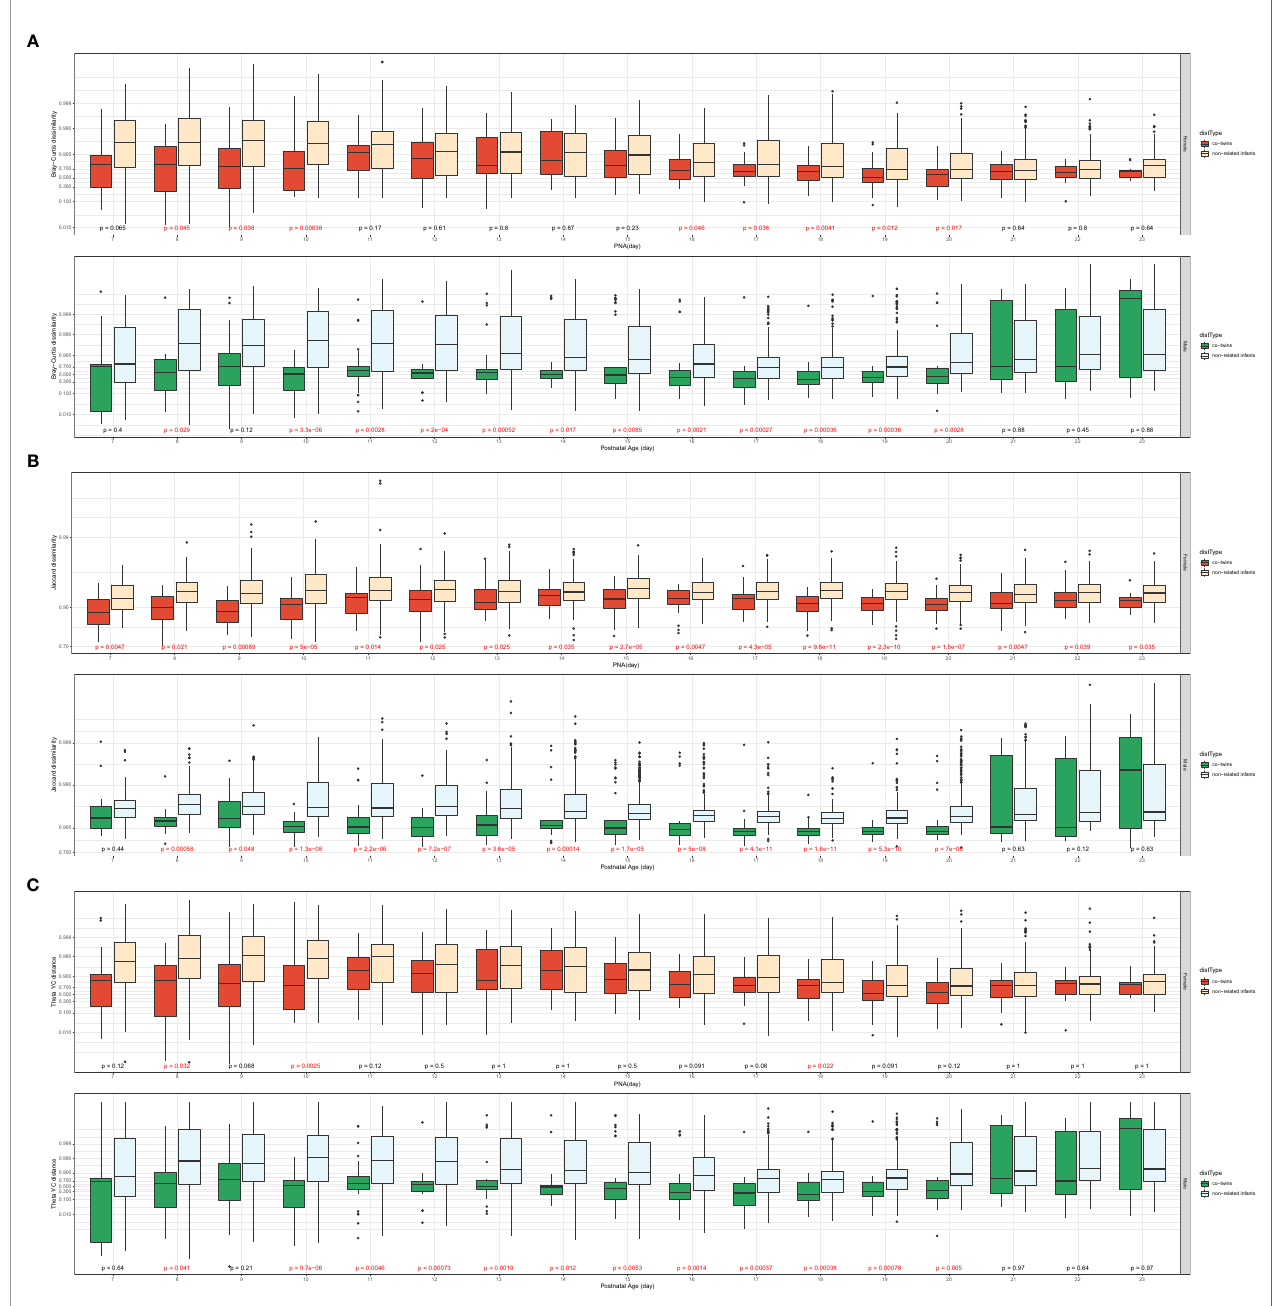
FIGURE 3 | Comparison of the b -diversity of the co-twins/triples with non-related infants from the same sex ( A : Bray-Curtis dissimilarity; B : Jaccard dissimilarity; C : Theta YC distance). In each of the sub fi gures, top panel: Female T/T (Mann-Whitney U test, signi fi cant p values colored in red); bottom panel: Male T (Mann- Whitney U test, signi fi cant p values colored in red); x-axis: the averaged postnatal age for sample pairs; y-axis: the logit-transformed b -diversity measures between 0 and